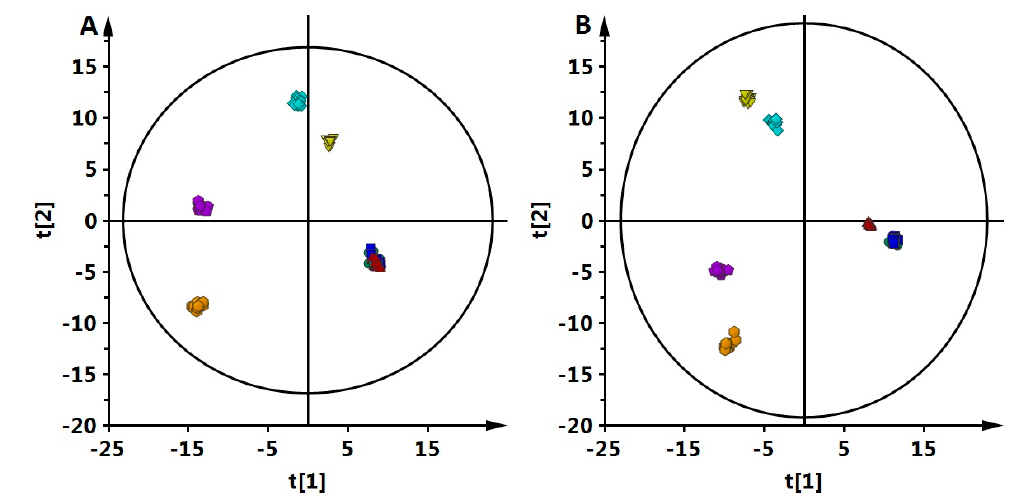
Figure 2. A PLS-DA score plot was obtained for all time points.